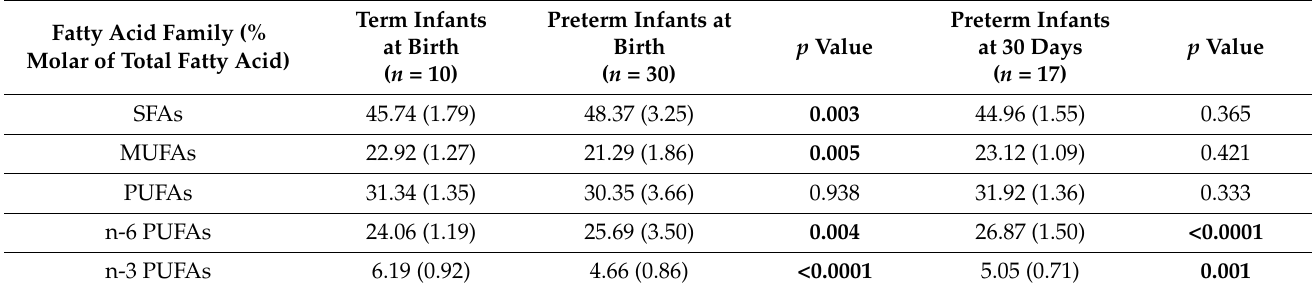
Table 2. Content of fatty acid families in erythrocyte membranes at birth and at 30 days of life in preterm neonates as compared with infants born at